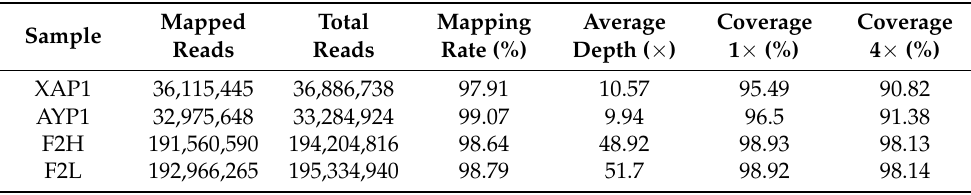
Table 1. Quality statistics of mapping with the reference genome for